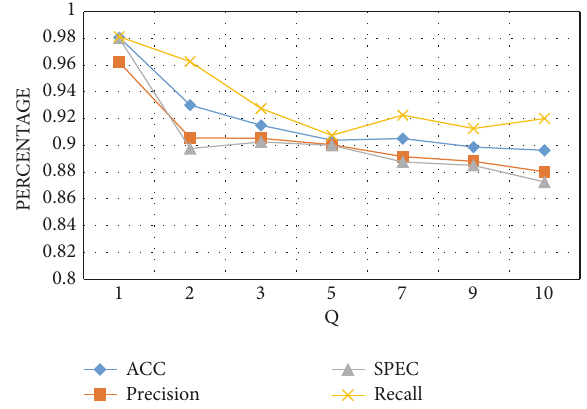
Figure 7: The classification rules obtained from the proposed system to classify the seizure-free (0) and the epileptic seizure (1)